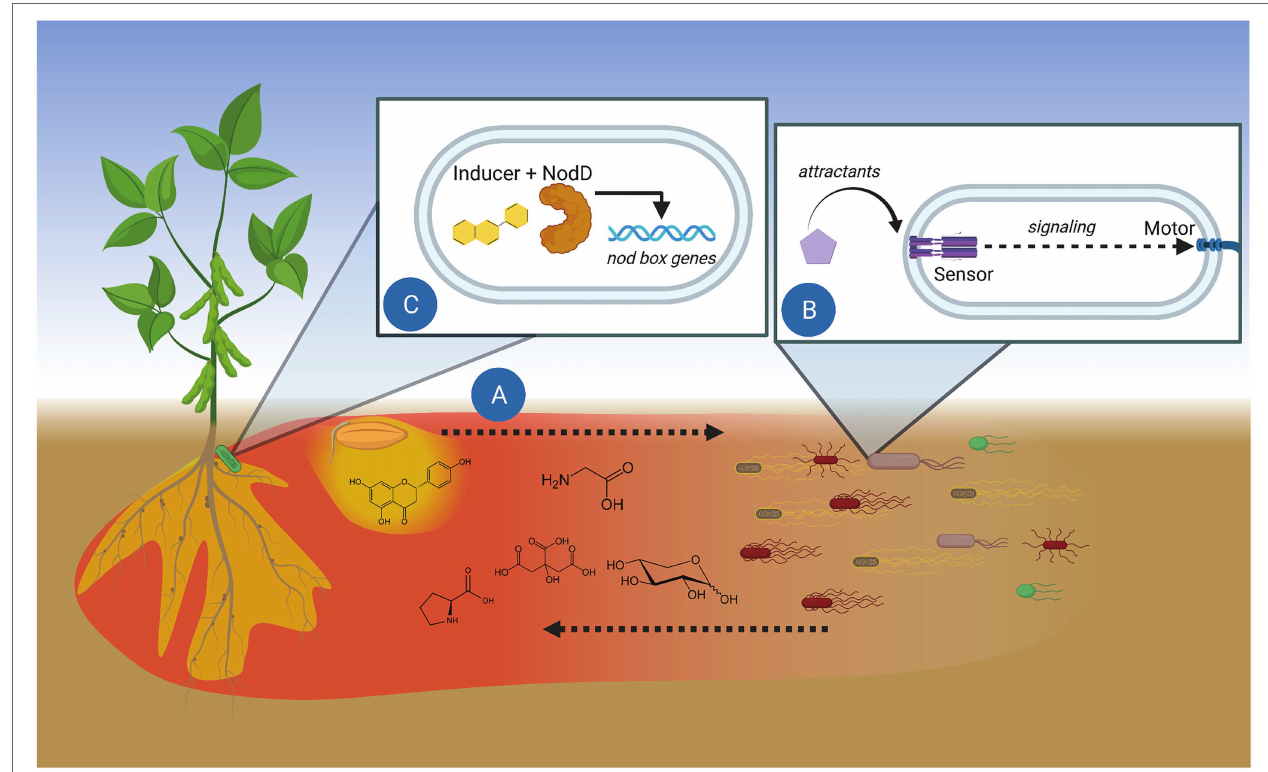
FIGURE 1 | Model of chemotaxis function in the initiation of rhizobium-legume symbiosis. (A) Root and seed exudates diffuse and create chemical trails. Gradients of soluble exudates (red) travel furthest and act as chemoattractants. Hydrophobic exudate components (yellow) stay closer to the source. (B) Specific exuded compounds are detected by bacterial methyl-accepting chemotaxis proteins (MCPs), the dedicated sensors of attractants. Signaling between the chemosensory system and the motor guides the bacterium toward the attractant source. (C) Perception of plant flavonoids by rhizobial NodD initiates transcription of genes involved in infecting the proper host. Figure created with